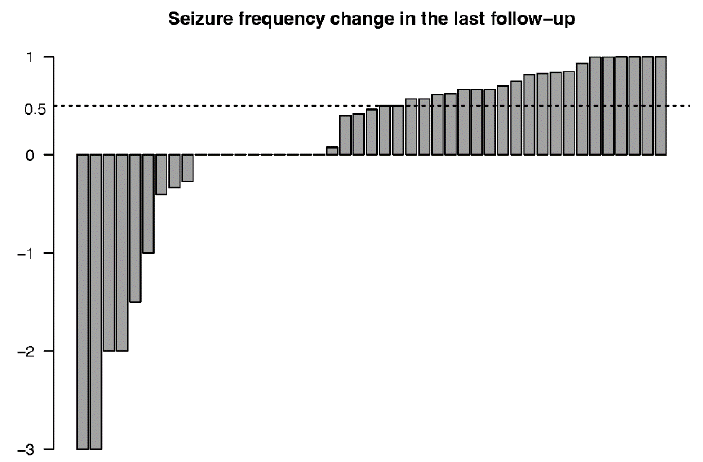
Figure 1. Bar chart of seizure frequency changes for every individual at the final